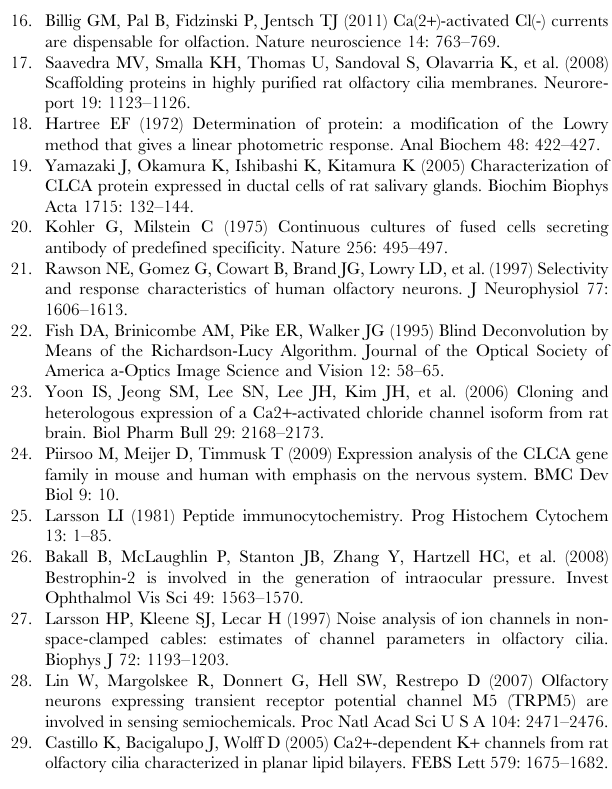
Figure S2 PCR and immunohistochemical studies con- sistent with the presence of ANO2 in the cilia of olfactory sensory neurons. A. PCR fragments amplified with primers shown in Table S4. B. Immunohistochemical demonstration of the presence of ANO2 (green) and CNGA2 (red) in the cilia of an isolated olfactory sensory neuron. This is representative of images obtained from 22 OSNs. Figure S3 Four examples of immunolabeling of disso- ciated olfactory neurons (A–D) and lack of immunola- beling of cells with morphology different from OSNs (E– H). OSNs in A and B do not show immunolabeling to ClCa in the cilia while those in C and D do immunolabel for ciliary ClCa. A–E and G were co-labeled with anti-ClCa (green) and anti-CNGA2 (red) antibodies. E and G are DIC corresponding to F and H. Bars are 5 m m. Figure S4 High magnification image of the ciliary layer of the olfactory epithelium with anti-ClCa (green), anti- ANO2 (red). While the cilia layer is labeled by both antibodies with significant overlap there are areas of the ciliary layer where these two antibodies do not overlap (arrows). Bar is 10 m m. This was obtained as a single image with a 60x oil objective. Table S1 Information for nested primers for ClCa and CNGA2 (Fig. 1). The table includes the sequence and specification of each nested primer used to amplify mRNA of ClCa and CNGA2 to obtain the PCR products shown in Fig. 1. Forward (F) and reverse (R) primers for the first (F1/R1) and second (F2/R2) rounds of amplification are included.